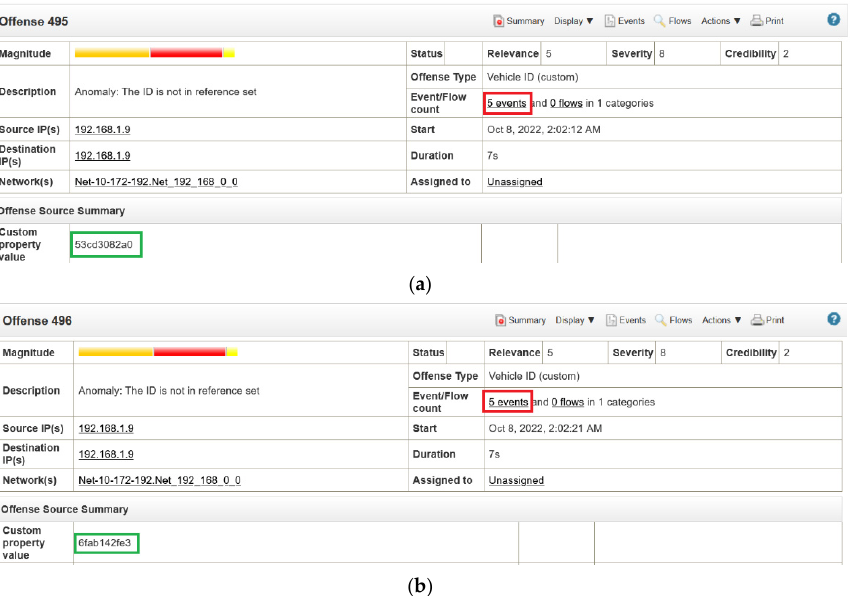
Figure 16. The actions chosen for the fuzzing attack.